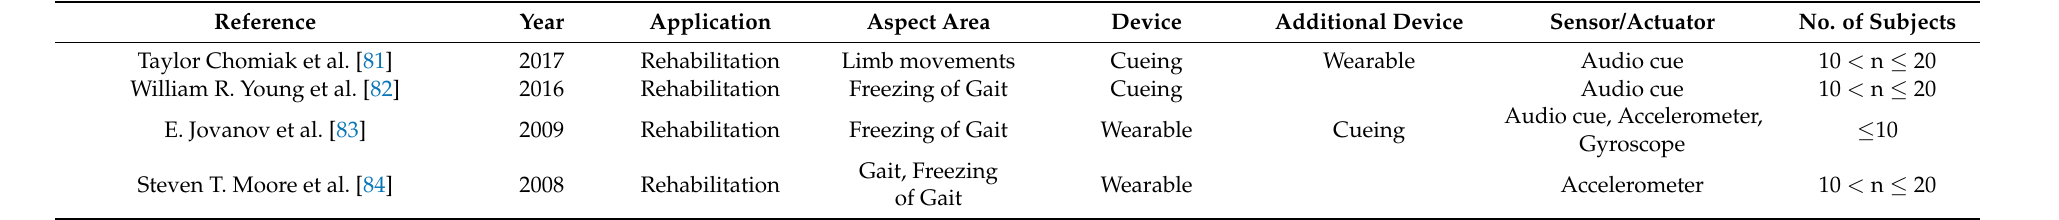
Table A2. Papers about